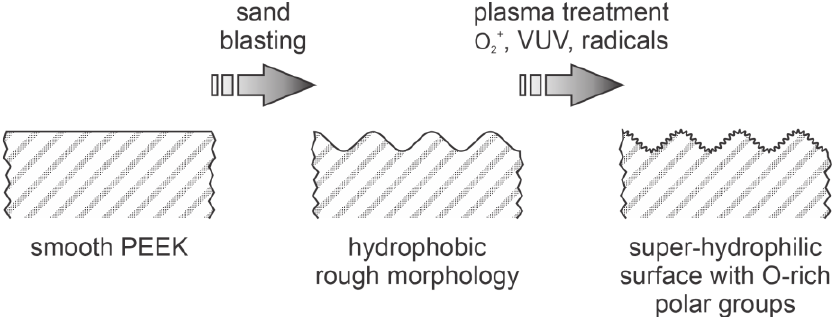
Figure 4. Schematic of the methods for super-hydrophilic surface finish of PEEK